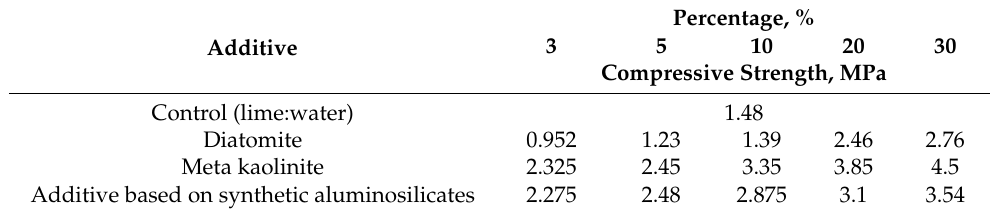
Table 7. The value of the compressive strength of lime composites with additives after 28 days.